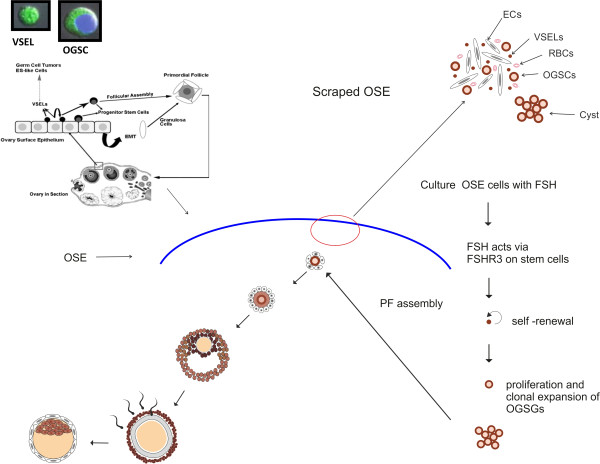
Schematic representation of the study results towards better understanding of postnatal oogenesis and follicle assembly. Small insert represents a model proposed earlier by us [34]. Blue line represents sheep ovarian surface epithelium (OSE). Gentle scraping of OSE shows the presence of epithelial cells (ECs), red blood cells (RBCs) and stem cells (VSELs, OGSCs and cysts). A crucial pluripotent marker OCT-4 (represented in brown) shows nuclear expression in VSELs and cytoplasmic in OGSCs and cyst. FSH acts via FSH receptor isoform R3 (rather than the canonical R1 isoform) on the stem cells and regulates self-renewal of VSELs increased (Oct-4A and Sox-2) and clonal expansion of the OGSCs (increased Oct-4) and formation of cysts (rapid proliferation of OGSCs with incomplete cytokinesis). The OGSCs get surrounded by somatic granulosa cells (formed by epithelial-mesenchymal transition of OSE cells) resulting in primordial follicle (PF) assembly. PF undergo transition into primary follicle and OCT-4 is observed in the ooplasm in the developing oocytes whereas the surrounding granulosa cells remain distinctly negative. In pre-antral to antral follicles, OCT-4 expression gradually decreases in the ooplasm whereas cytoplasmic OCT-4 is observed in the surrounding granulosa cells and interestingly the staining is relatively dark in cumulus granulosa cells compared to distal granulosa cells (please refer to Figure 5). In vitro matured sheep oocytes show cytoplasmic OCT-4 staining in surrounding granulosa cells which is reduced in MII compared to MI oocytes. Nuclear OCT-4 reappears in the developing embryo post-fertilization providing it a pluripotent state. In addition to OCT-4, FSHR which is also required for initial stem cell function during oogenesis exhibited a similar staining pattern.